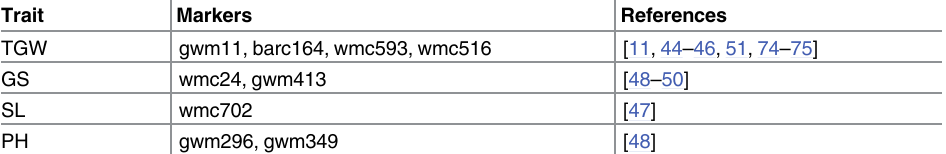
Table 9. List of significant MTAs involving nine SSR markers which did not qualify FDR criteria but reported in earlier studies. Trait